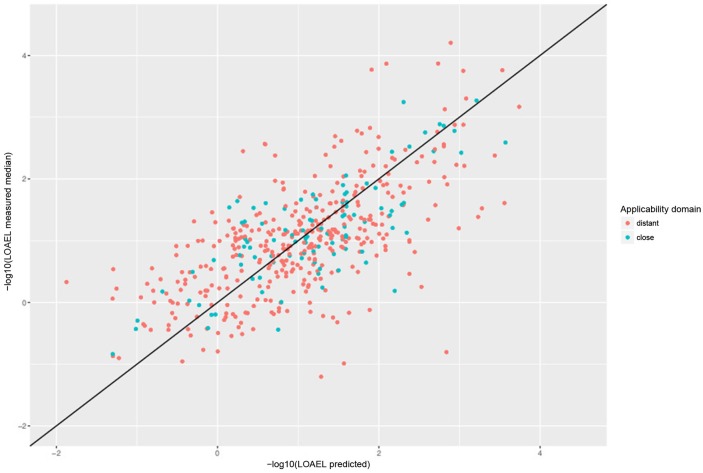
Correlation of predicted vs. measured values from a randomly selected crossvalidation with MP2D fingerprint descriptors and local random forest models.